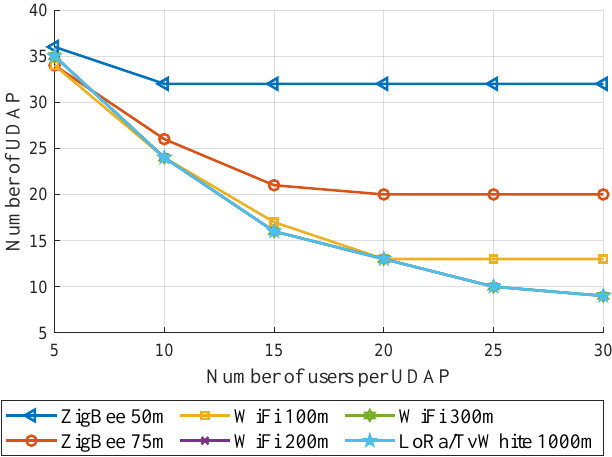
Figure 3. Number of users per UDAP vs. Number of